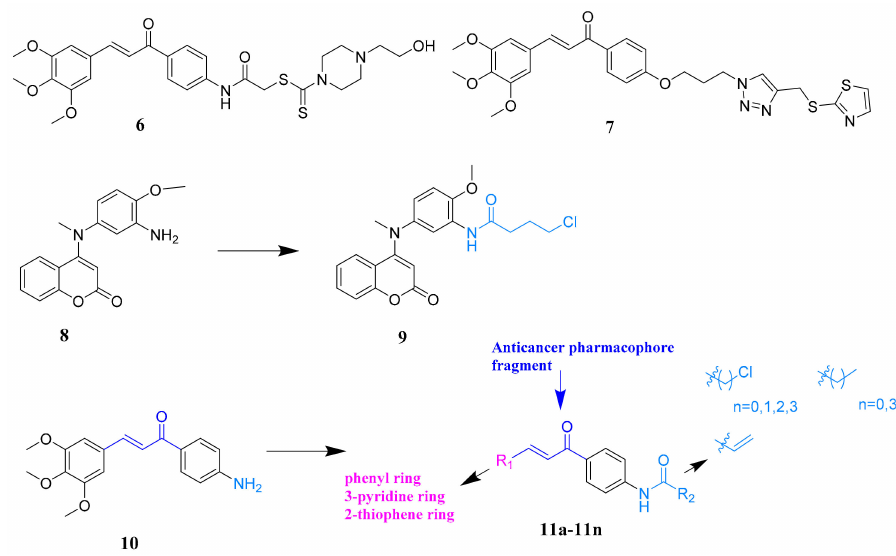
Figure 2. Reported and proposed anticancer chalcone and coumarin